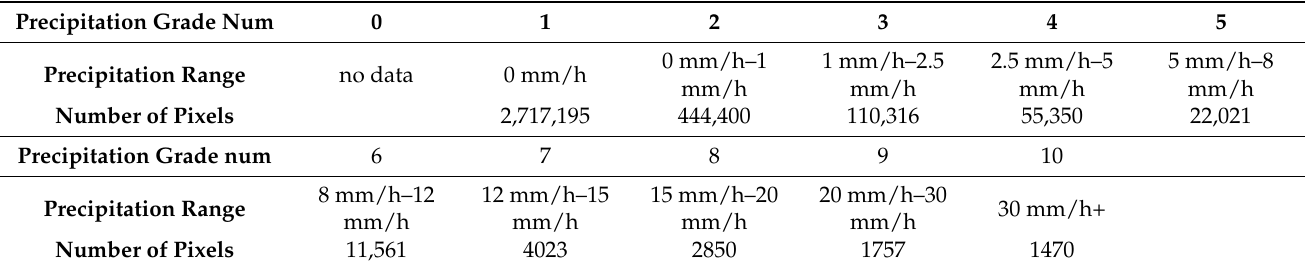
Table 5. Segment network precipitation grade, grade number, and the number of pixels each grade (number of pixels is obtained from IMERG precipitation data from 4 August 2021 to 7 October